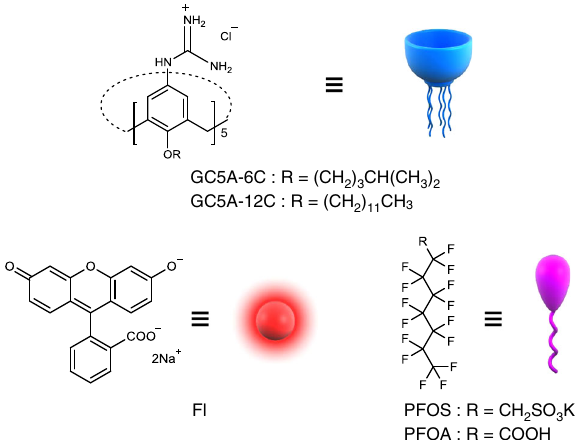
Fig. 1 Chemical structures of hosts and guests. Chemical structures of the employed calixarene hosts (GC5A-6C and GC5A-12C), the Fl reporter dye, and the per fl uorinated pollutants (PFOS and PFOA) in this